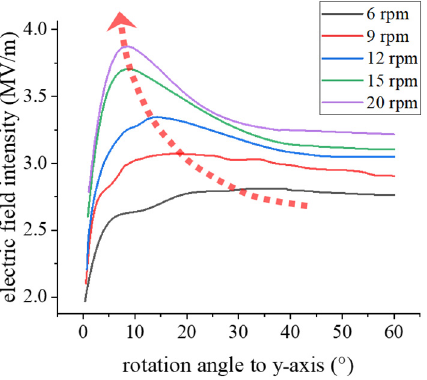
Figure 12. E ‐ field strength of blade tip with rotation angle and different speeds. Figure 12. E-field strength of blade tip with rotation angle and different